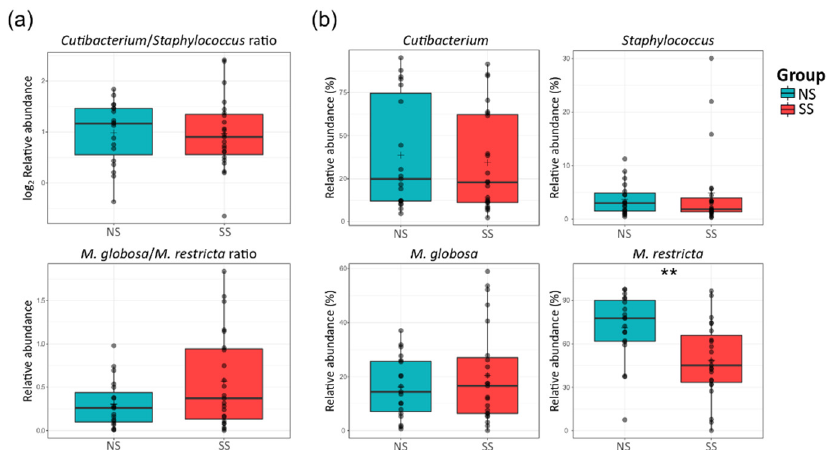
Figure 3. Proportions of the major bacterial genera ( Cutibacterium and Staphylococcus ) and fungal species ( M. globosa and M. restricta ) on the skin. ( a ) The ratio of Cutibacterium to Staphylococcus (log 2 scaled relative abundance) and that of M. globosa to M. restricta (relative abundance). ( b ) Boxplots of the relative abundances of the bacterial genera Cutibacterium and Staphylococcus , and fungal species M. globosa and M. restricta . The statistical significance of the differences between the skin groups is indicated by ns > 0.05 and ** p ≤ 0.01.